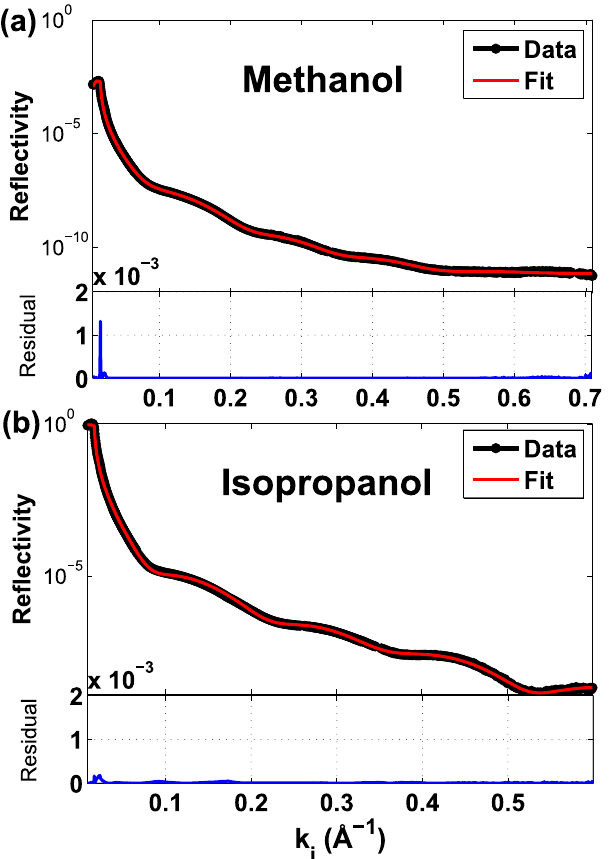
Figure 1. The best fit surface models. The best surface model (red line) fitted to the reflectivity data (black dots) of ( a ) methanol and ( b ) isopropanol adsorbed on calcite {10.4}. Residuals for the fit are plotted below each plot.